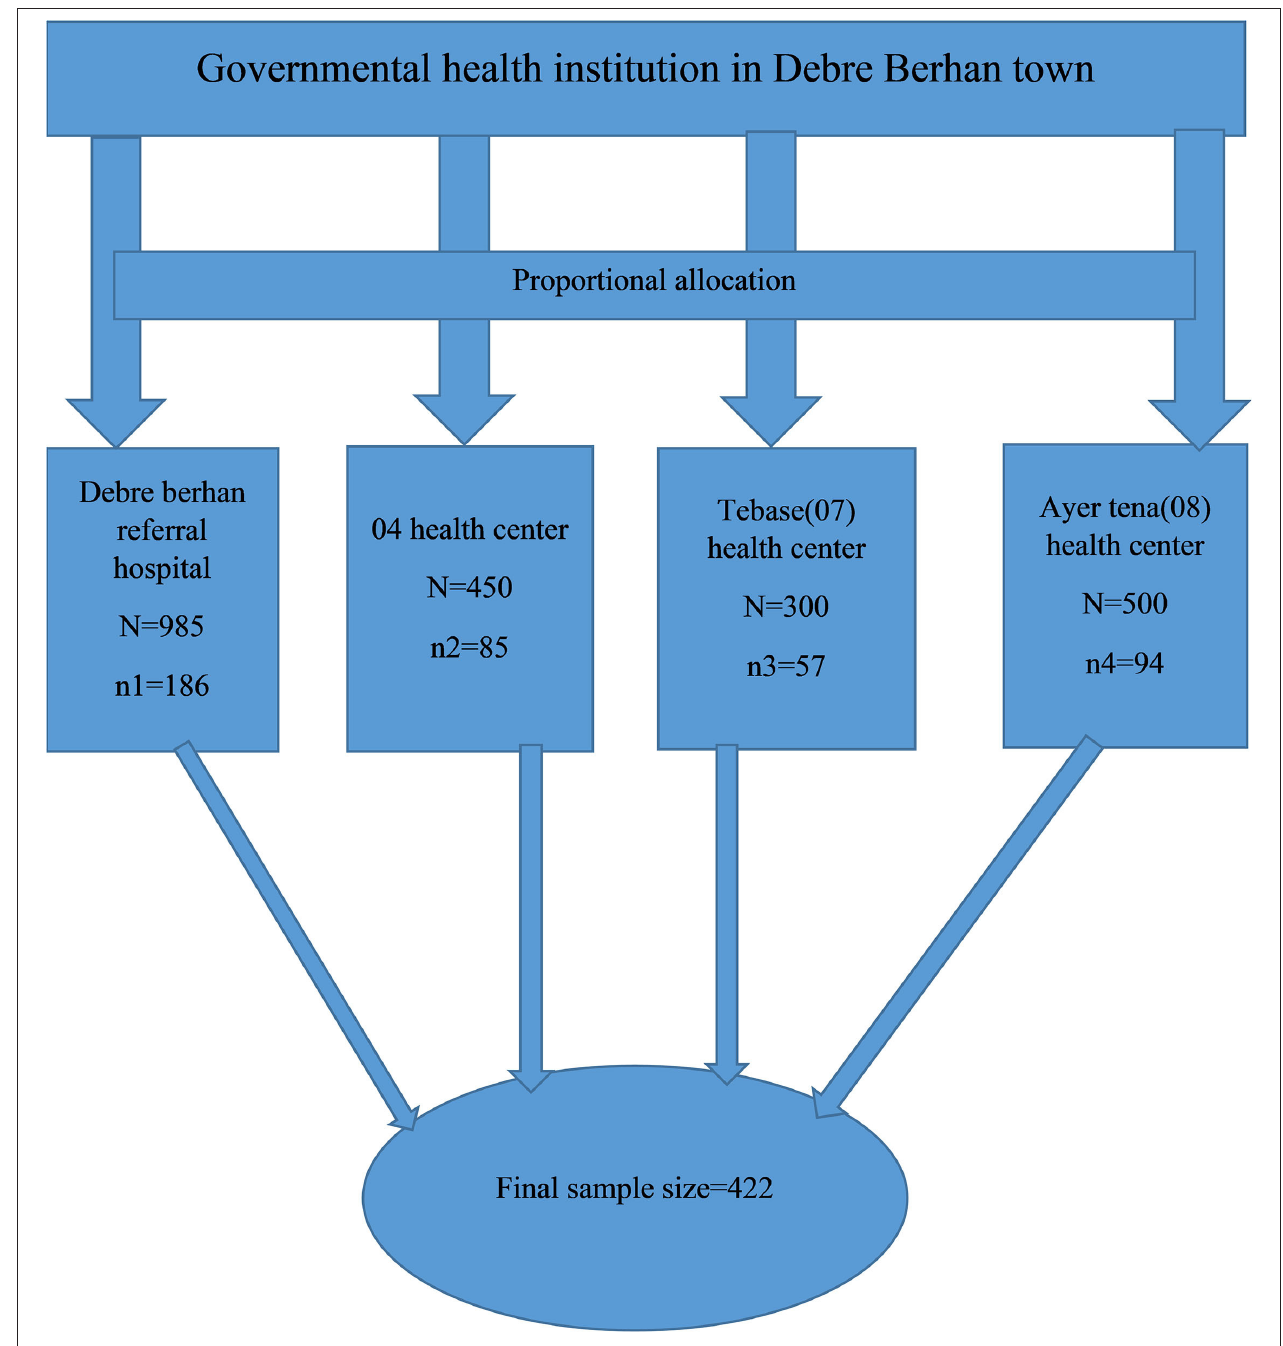
FIGURE 1 | Schematic presentation of sampling procedure of the